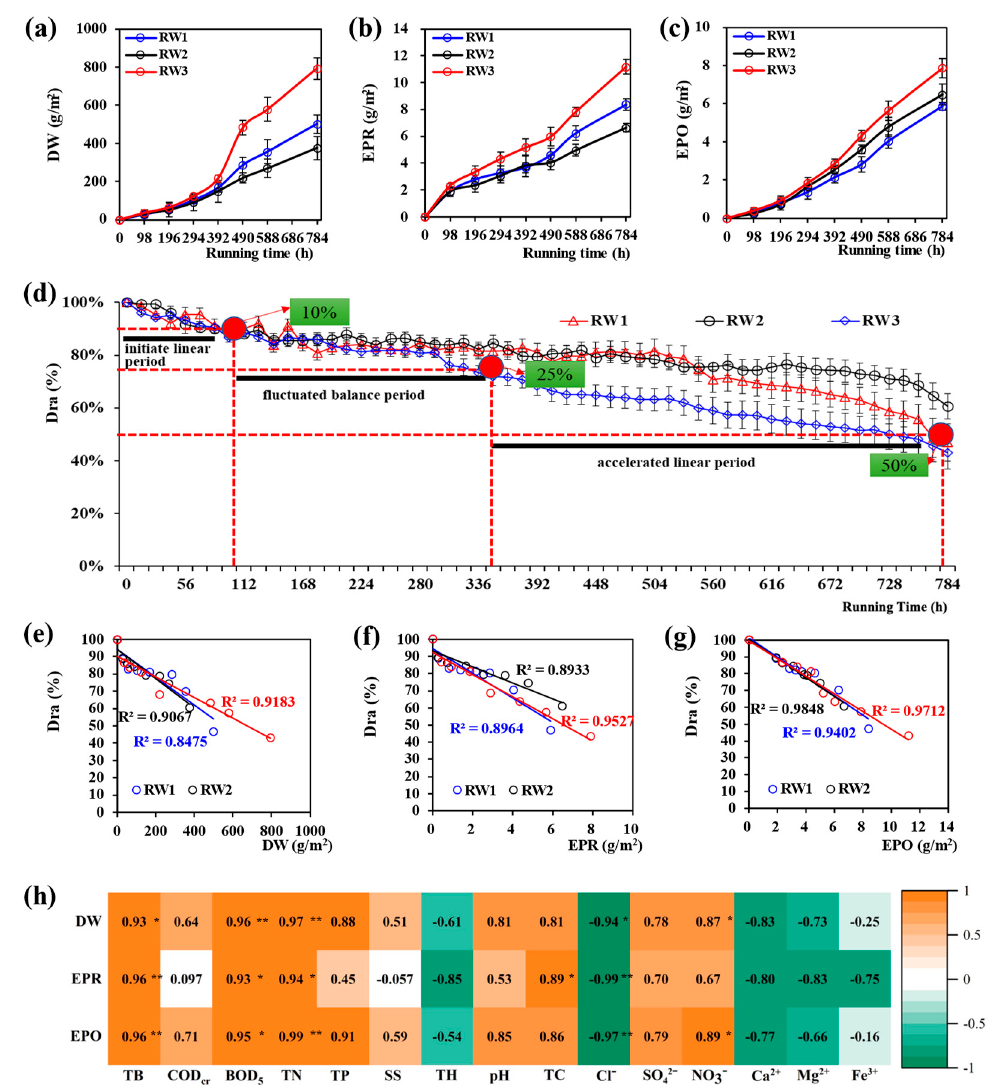
Figure 2. Biofilm composition and system performance of the drip irrigation system with RW1/2/3 as water sources. ( a – c ) The changes of DW, EPR, and EPO contents of biofilm, respectively; ( d ) The change pattern of Dra in the drip irrigation system under three reclaimed water conditions; ( e–g ) The correlation between Dra and DW, EPR, and EPO contents of biofilm, respectively; ( h ) The correlation between biofilm components and water quality. * indicates significance of p < 0.05, ** indicates significance of p < 0.01.